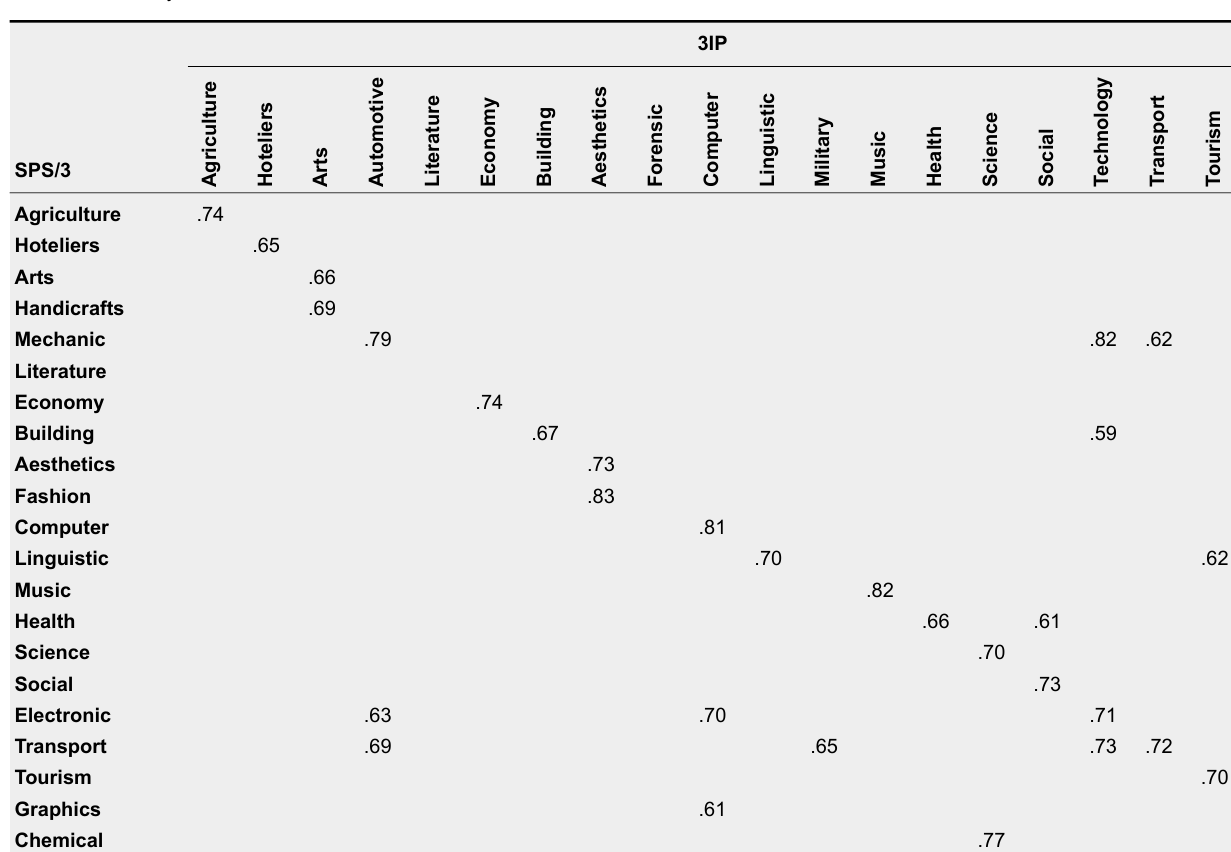
Concurrent Validity with